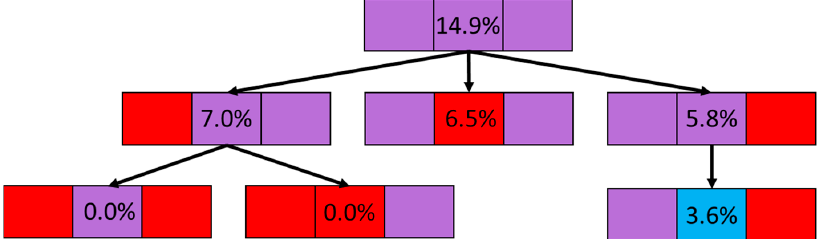
Figure 15. An example of how members of the initial population are randomly generated from the membrane reactor where red is for reactors, blue are membrane separators, and purple are membrane reactors (note that not all ten members are shown due to a lack of space). The % values shown inside the middle blocks are each design’s respective OI.